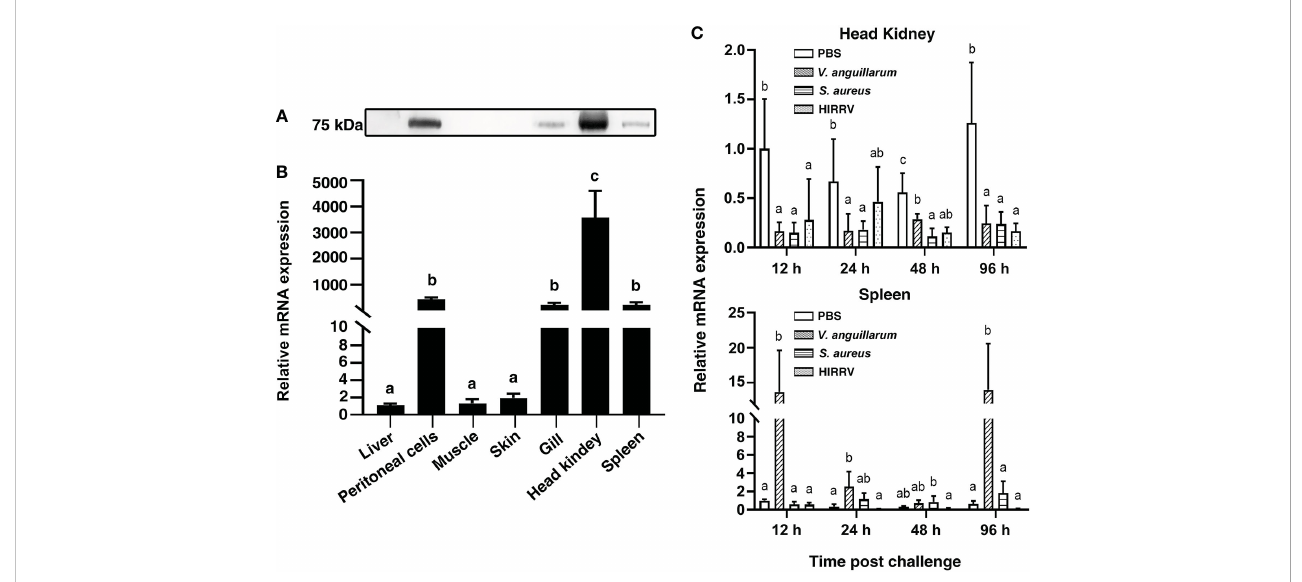
FIGURE 3 The expression of Po MPO was determined by Western blotting (A) and quantitative real-time PCR (B) in different tissues. (C) Relative gene expression of Po MPO in the head kidney at different time points after V. anguillarum , S. aureus , or HIRRV infection. The results were calculated using relative expression method with 18S as the housekeeping gene. Different letters above the bar represent the statistical signi fi cance ( p < 0.05) compared to each other at the same time point, and vertical bars represented the mean ± SD, n =